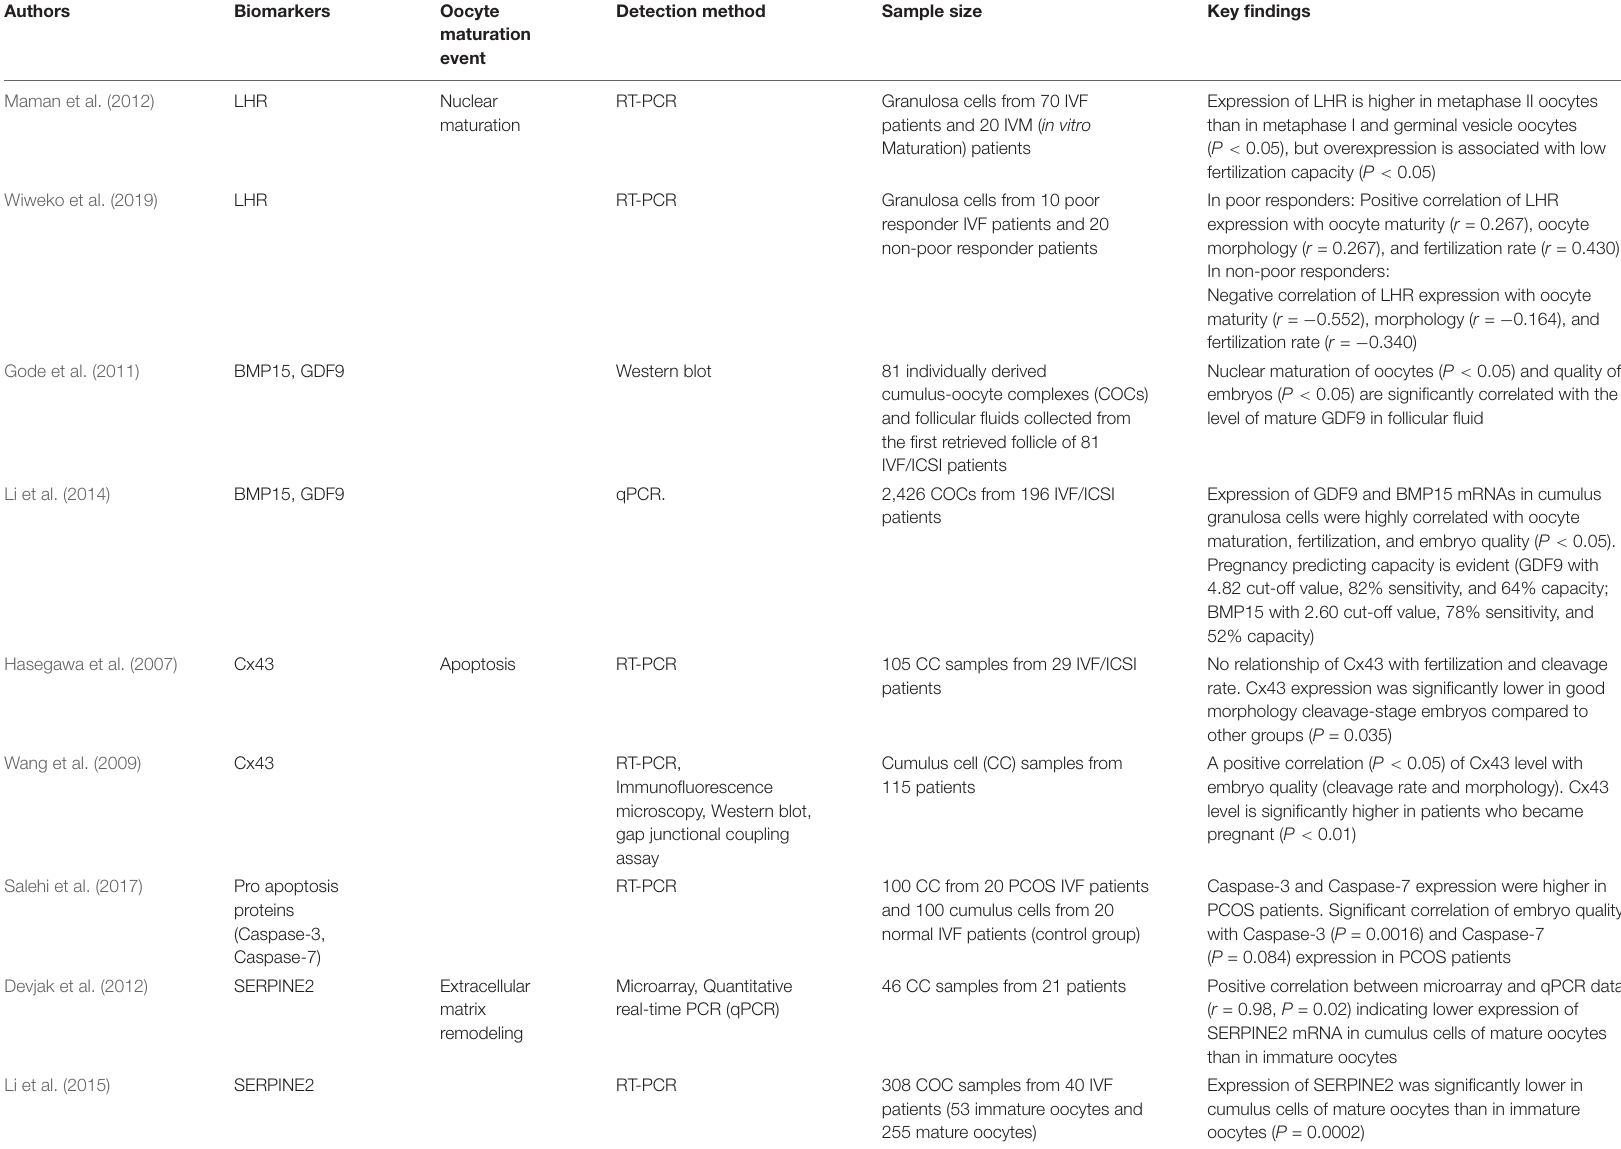
TABLE 1 | Summary table of eight cumulus biomarkers and their significance in assessing oocyte development competency and/or IVF